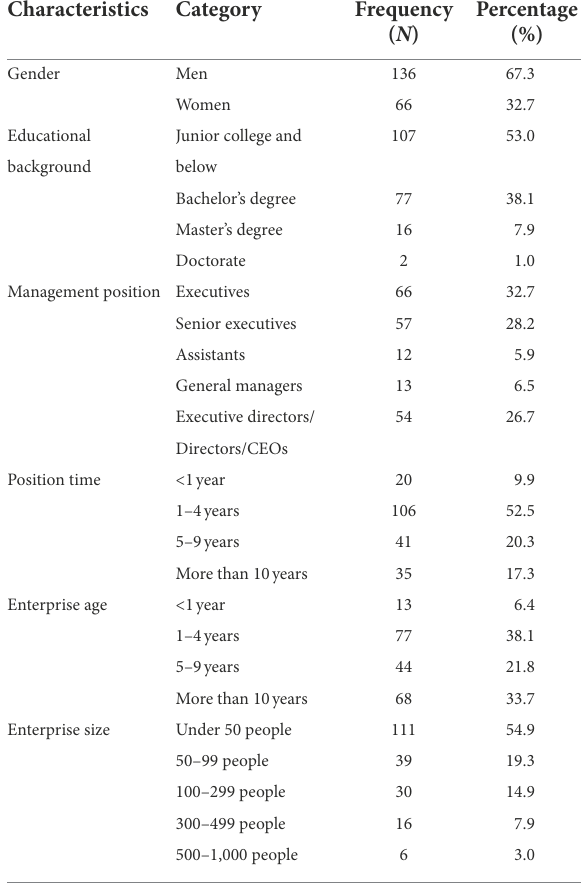
TABLE 1 Distribution of respondent characteristics ( N =